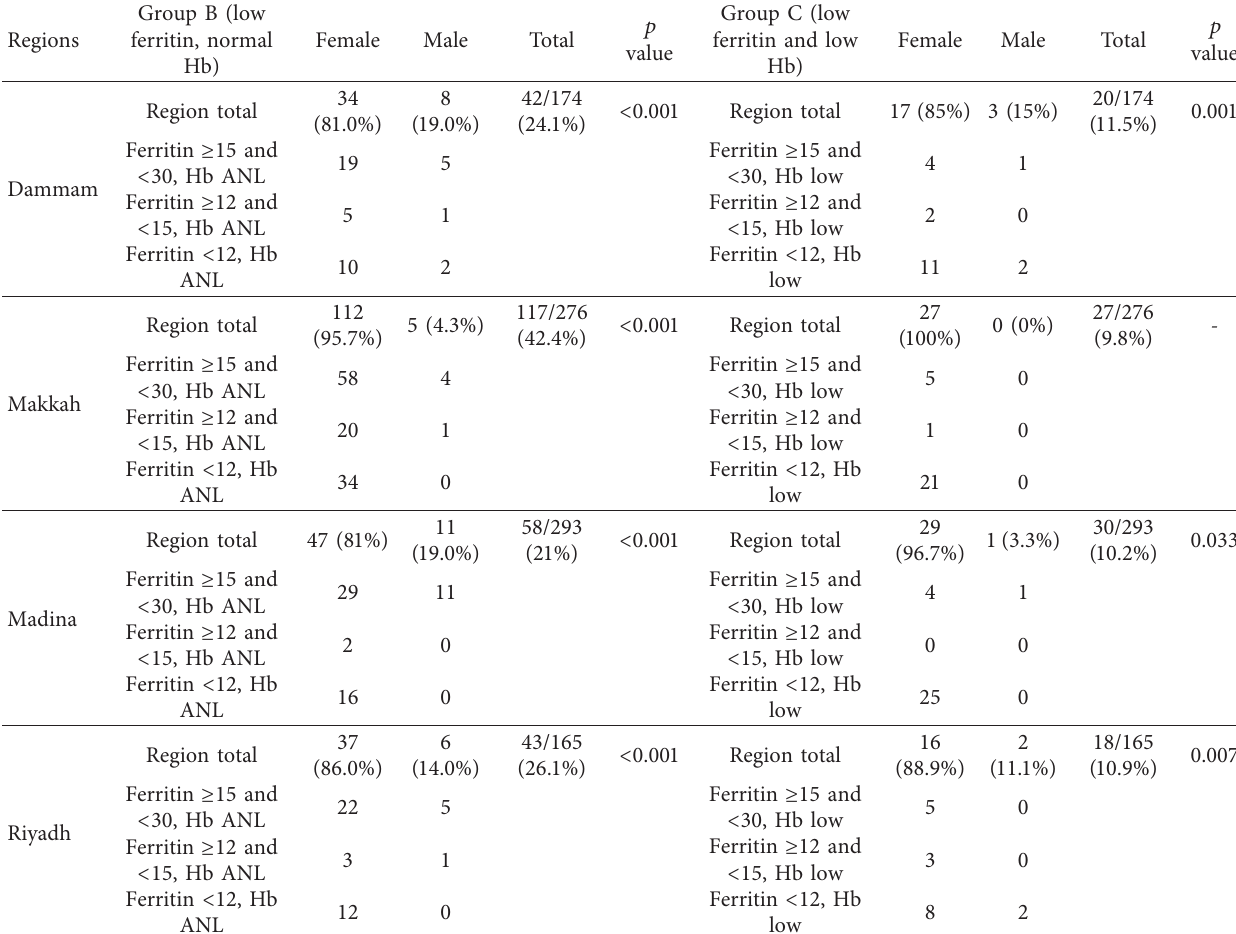
Table 4: Observations based on the hematological profile (excluding cases of thalassemia and sickle cell disease) by regions with confirmed lab values ( n �